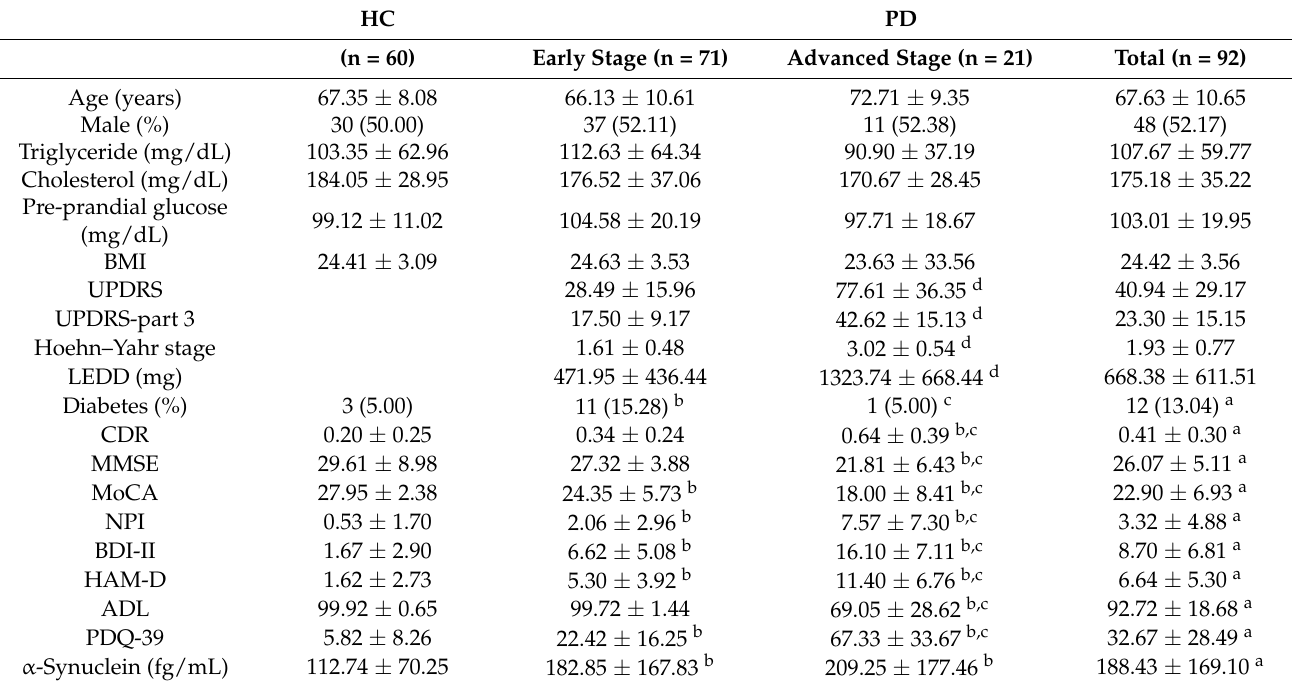
Table 1. Demographic characteristics and blood biochemical parameters of included patients with Parkinson’s disease (PD) and the healthy controls (HC).